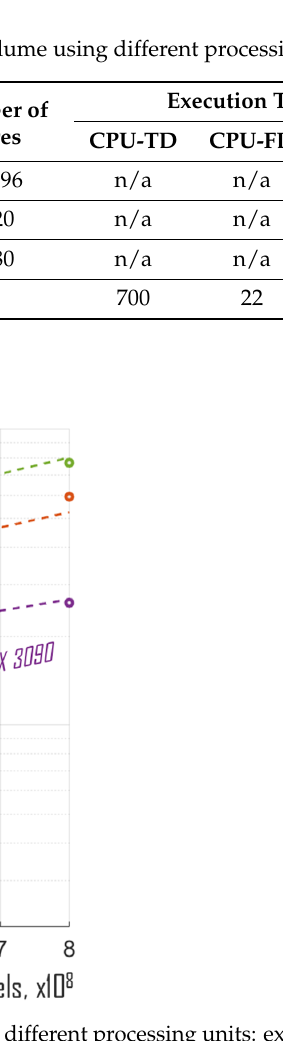
Figure 5. Execution times for different voxel counts and different processing units: experimental data (markers); and theoretical data (dotted curves).